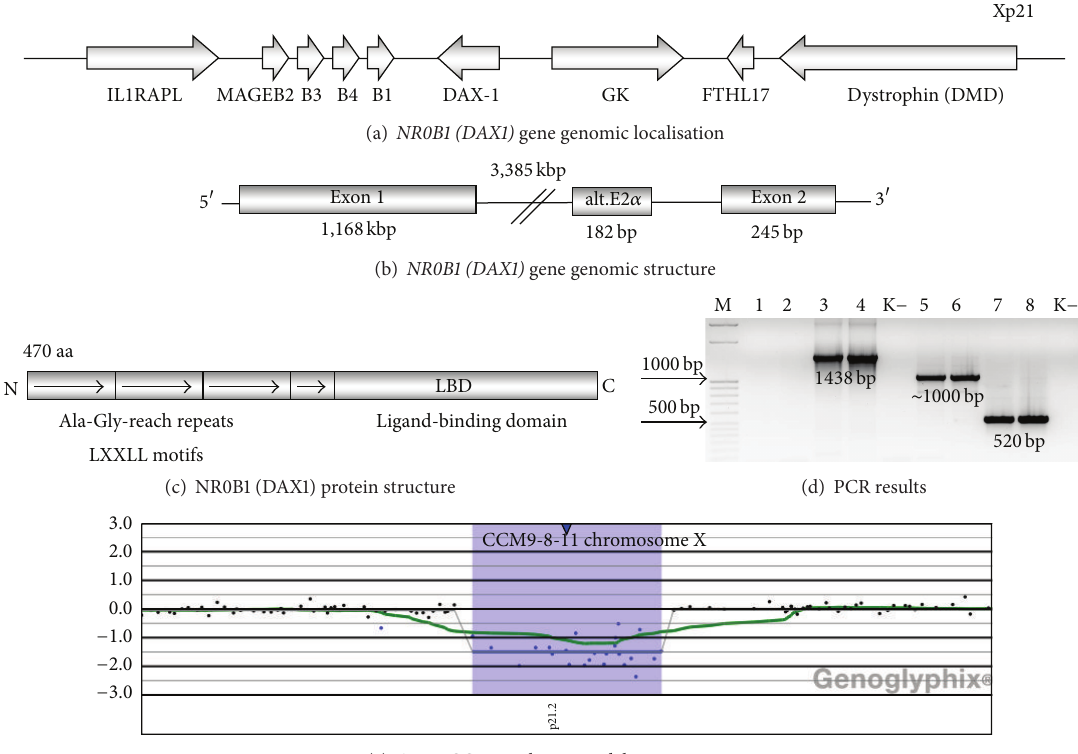
Figure 1: (a) Schematic representation of NR0B1 (DAX1) gene localisation in the Xp21 region of the X chromosome between the IL1RAPL1 and dystrophin ( DMD ) genes. IL1RAPL1 encodes for a putative transmembrane cytokine receptor related to receptors and receptor accessory proteins for interleukin 1 and interleukin 18 and is expressed in the brain and muscles. The MAGEB (melanoma antigen family B) gene cluster encompasses the MAGEB1 , B2 , B3 , and B4 genes, which are expressed in tumor cells but are silent in normal adult tissues except for the male germ line cells. NR0B1 (DAX1) , GK : glycerol kinase gene, FTHL17 : the testis specific ferritin heavy chain gene, and DMD : dystrophin gene. (b) Genomic structure of the NR0B1 (DAX1) gene composed of two exons (exon 1 and 2). Alternatively spliced exon 2 𝛼 located within the intron is also shown. (c) Functional domain structure of the NR0B1 (DAX1) protein. NR0B1 (DAX1) protein has 470 amino acids and belongs to the nuclear hormone receptor superfamily. NR0B1 (DAX1) displays a novel DNA-binding domain at its amino terminus. This N-terminal repeat region with LXXLL motifs is crucial for protein-protein interactions. The three total repeats and fourth incomplete repeat of a 65- to 67-amino acid sequence, rich in alanine and glycine, are indicated by arrows. The C-terminal part of the NR0B1 (DAX1) protein shows the characteristics of a nuclear hormone receptor ligand-binding domain (LBD) and functions as a transcriptional repression domain. (d) PCR analysis of the NR0B1 (DAX1) gene results. M: DNA molecular weight 50 bp marker (Sigma), lanes 1-2: no amplification of exon 1 in